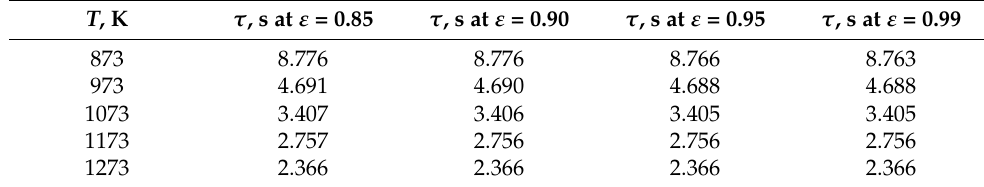
Table 2. Ignition delay times under radiant heating when the emissivity value is varied.